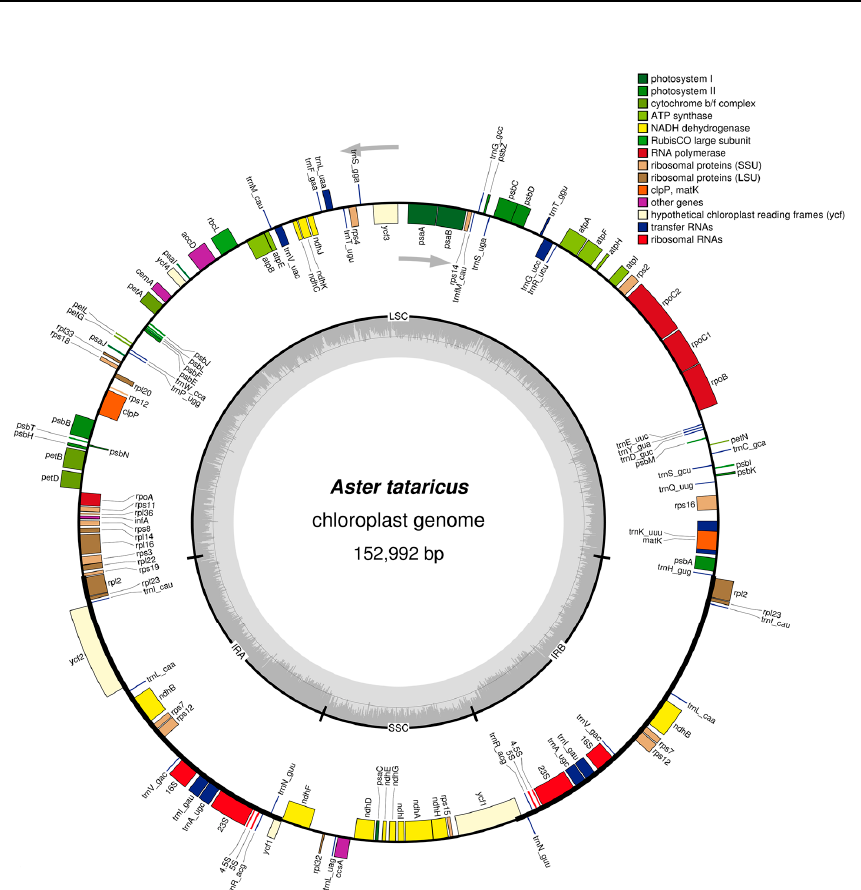
Figure 1. Gene map of the A. tataricus chloroplast genome. Genes drawn inside the circle are transcribed clockwise, and those outside are transcribed counterclockwise. Genes belonging to different functional groups are color-coded. The darker gray in the inner circle corresponds to DNA G + C content, while the lighter gray corresponds to A + T content.